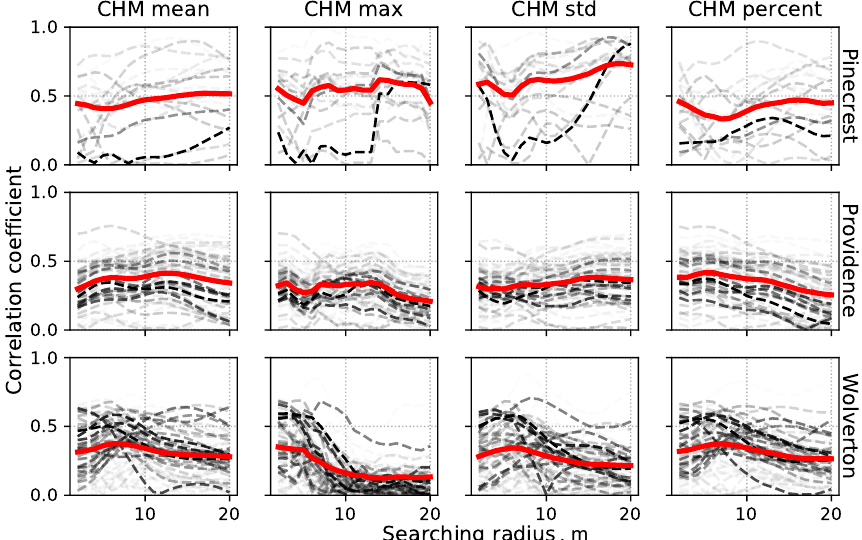
Figure 9. Correlation coefficients between different types of lidar-derived vegetation attributes and total precipitation of each event over increasing search radius used in calcualating the attribute from lidar. The red curves represent the mean correlation coefficients across all precipitation events. The darkness of gray curves represent the magnitude of each precipitation